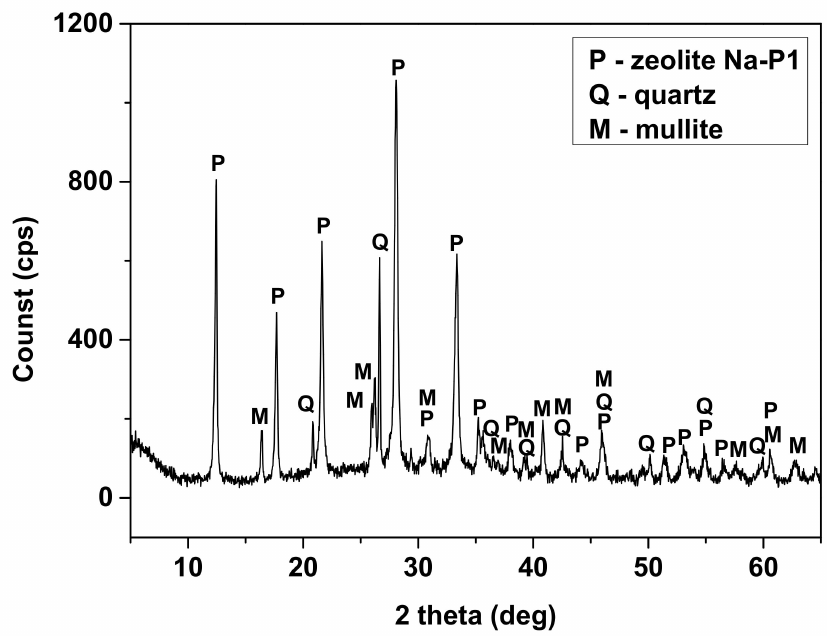
Figure 1. XRD patterns of NaP1.